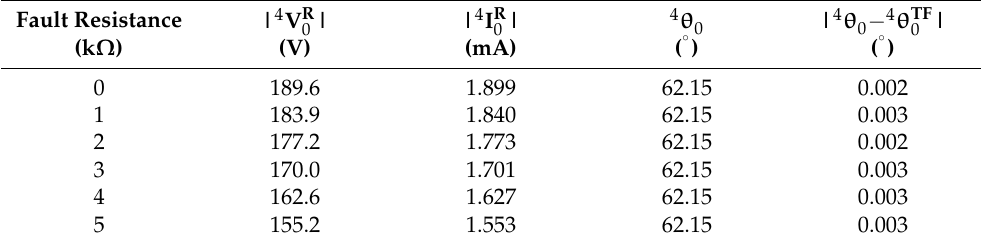
Table 2. Test results for SLG faults in the fourth feeder with different fault resistances.